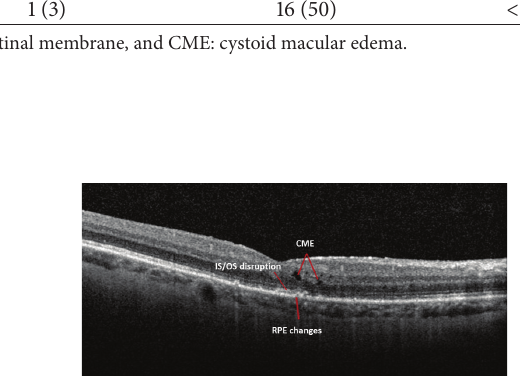
Figure 1: SD-OCT image of a 63-year-old patient one year after anatomical repair of a macula-on RRD with 3PPV + SF6. We can notice the presence of CME, IS/OS (ellipsoid zone) disruption, and RPE